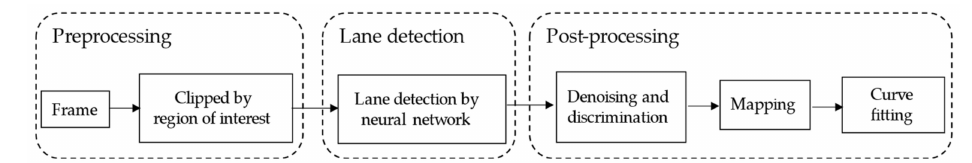
Figure 2. Lane detection block diagram.